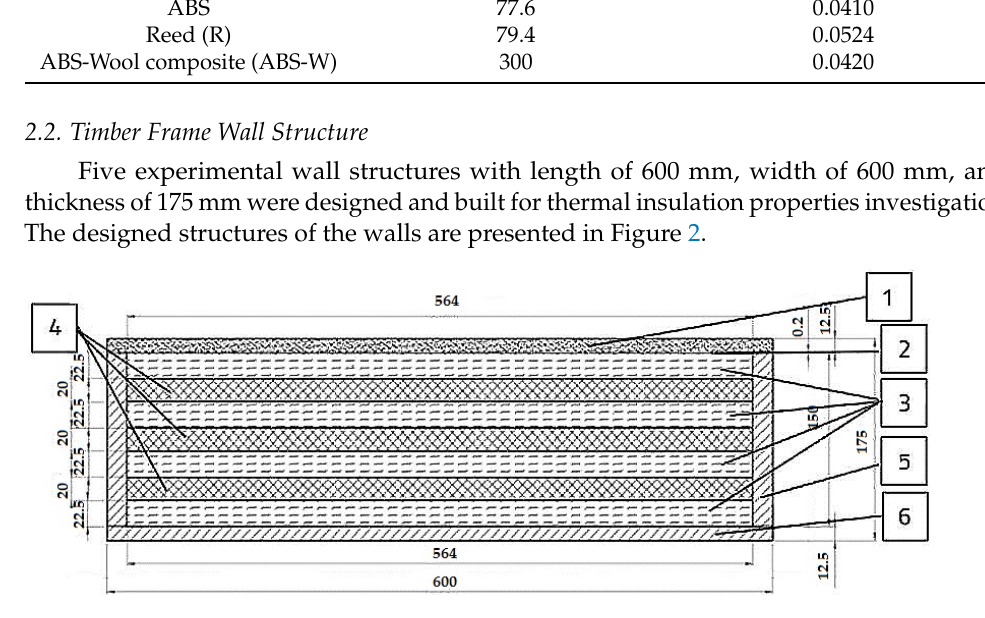
Figure 2. The structure of the timber frame wall: 1—gypsum board; 2—aluminum foil; 3—fillers; 4—ABS-wool composites; 5—particleboard; 6—OSB.